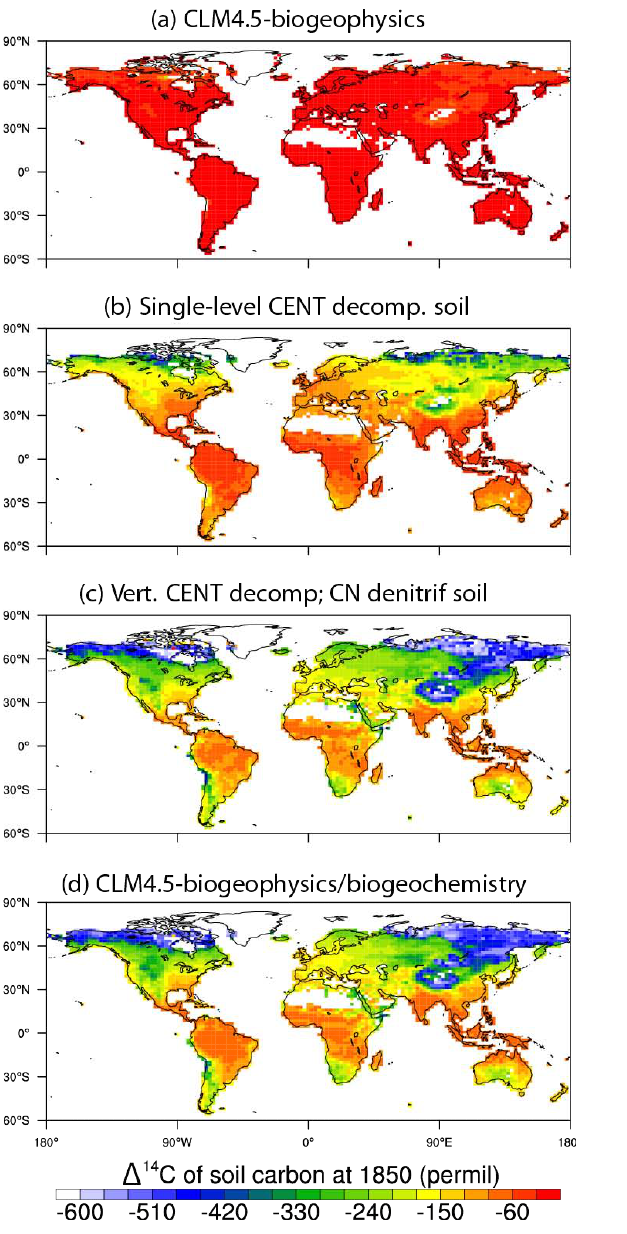
Fig. 6. Maps of SOM 1 14 C for various cases: (a) base CLM4.5-biogeophysics; (b) single-level BGC, Century-based